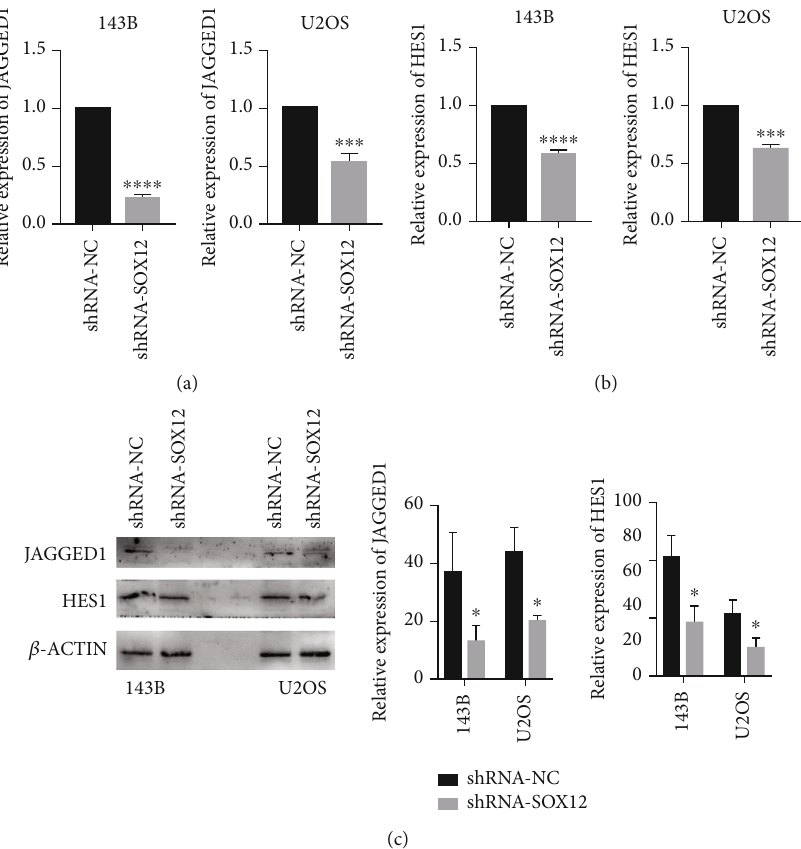
Figure 6: SOX12 knockdown reduces JAGGED1 and HES1 expression. (a) SOX12 knockdown in osteosarcoma cells inhibits JAGGED1 mRNA expression. (b) SOX12 knockdown in osteosarcoma cells inhibits HES1 mRNA expression. (c) SOX12 knockdown in osteosarcoma cells inhibits JAGGED1 and HES1 protein expression. ∗ p < 0 : 01 , ∗∗∗ p < 0 : 001 , ∗∗∗∗ p < 0 : 0001